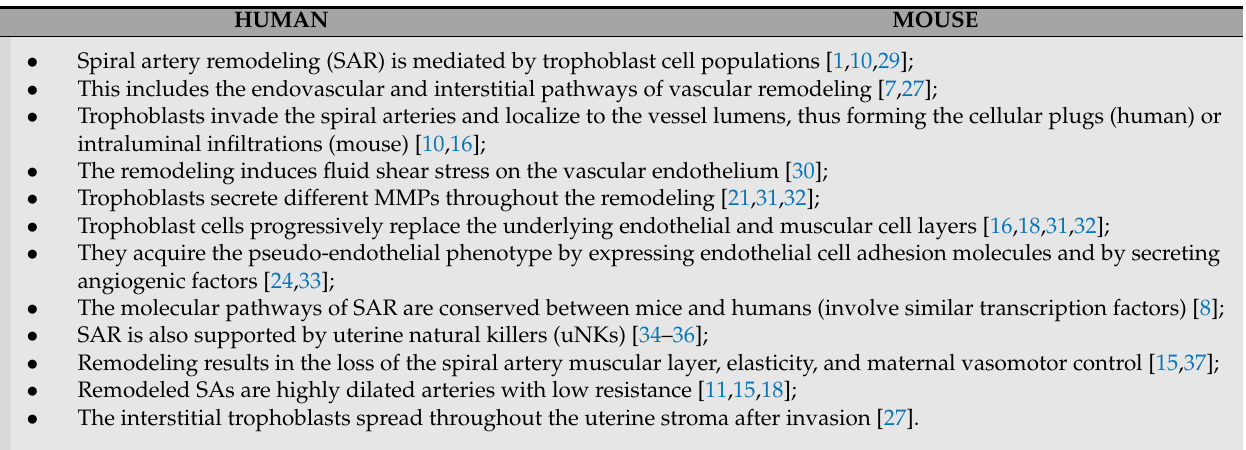
Table 1. Comparative characteristics of human and mouse spiral artery